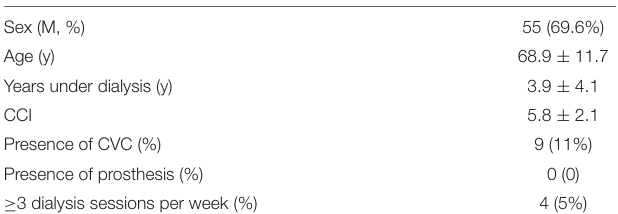
TABLE 2 | Main characteristics of the patients under dialysis procedure included in the pilot project at san feliciano